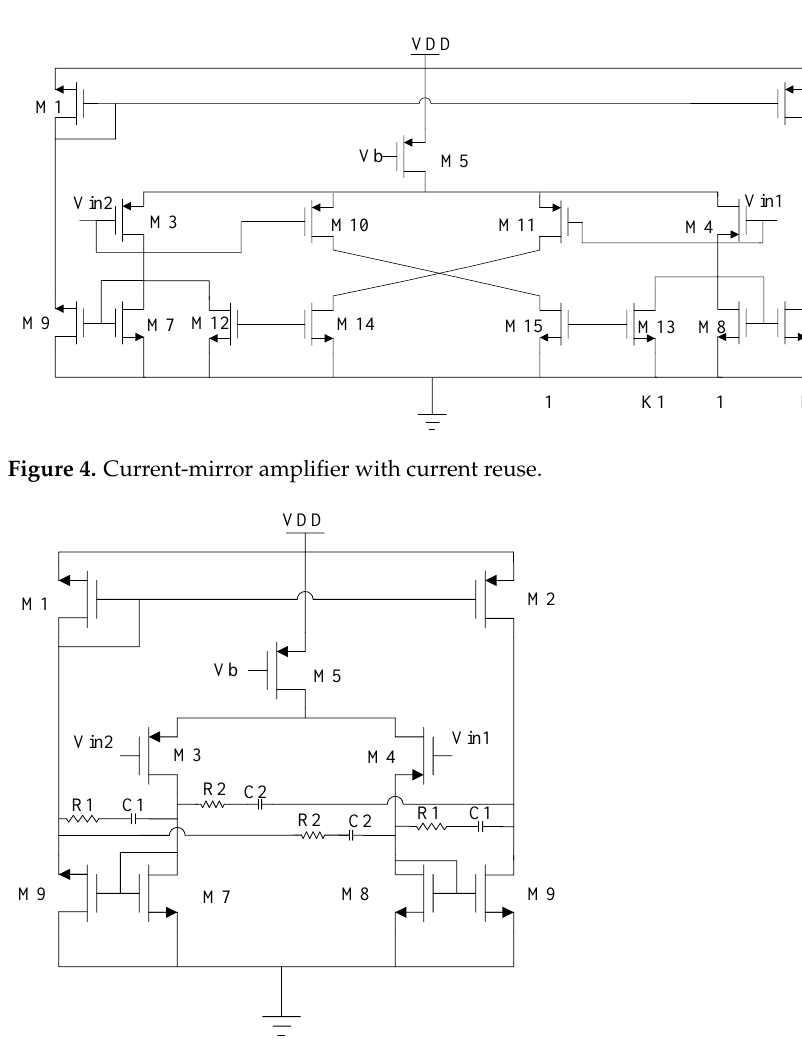
Figure 5. Schematic diagram of phase enhancement method circuit.